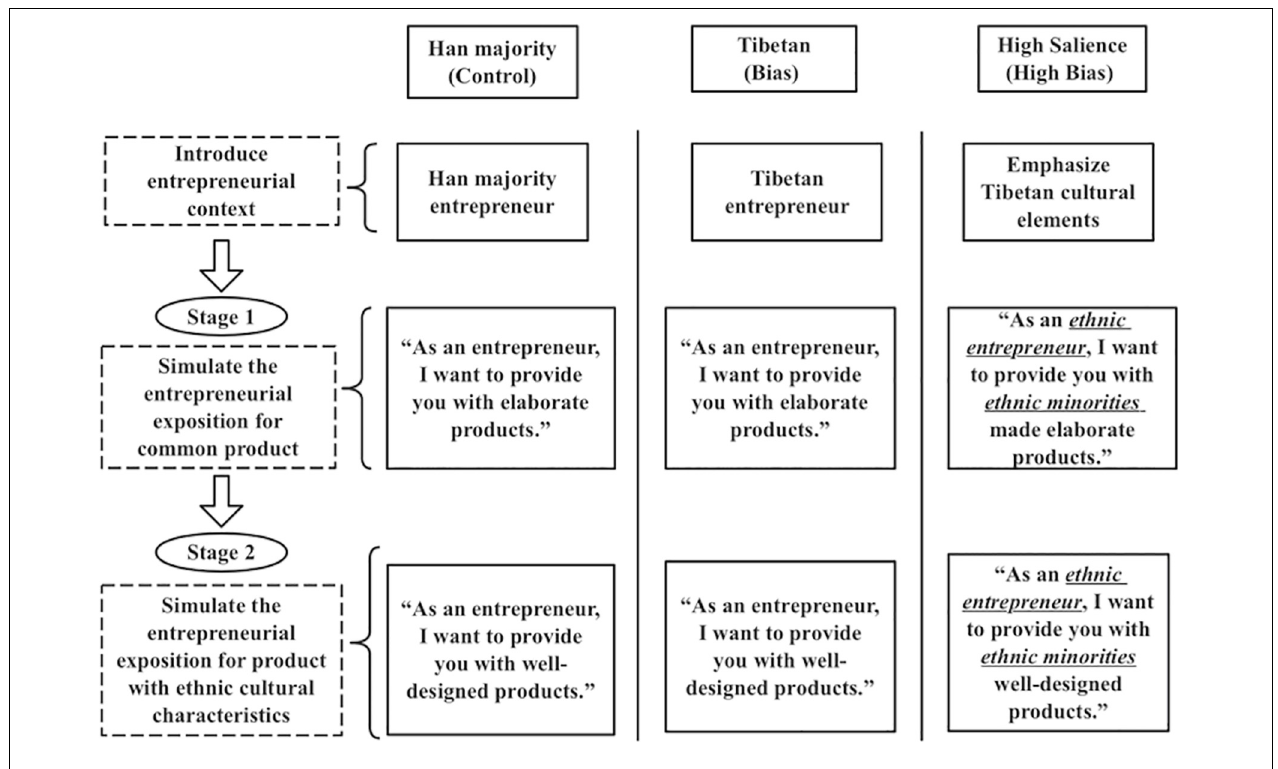
FIGURE 2 | The flow of experiment. TABLE 1 | Descriptive statistics and correlations. Variables